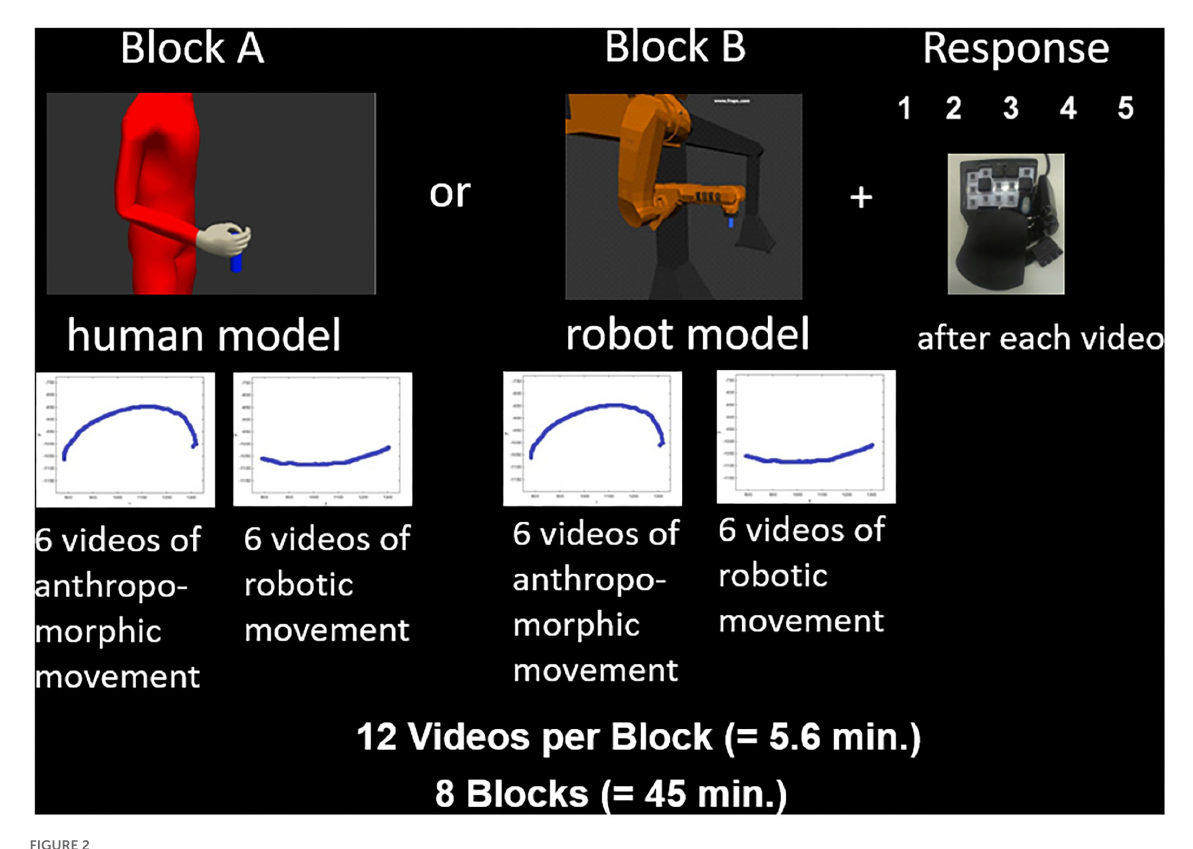
FIGURE2 Study design of a fMRT